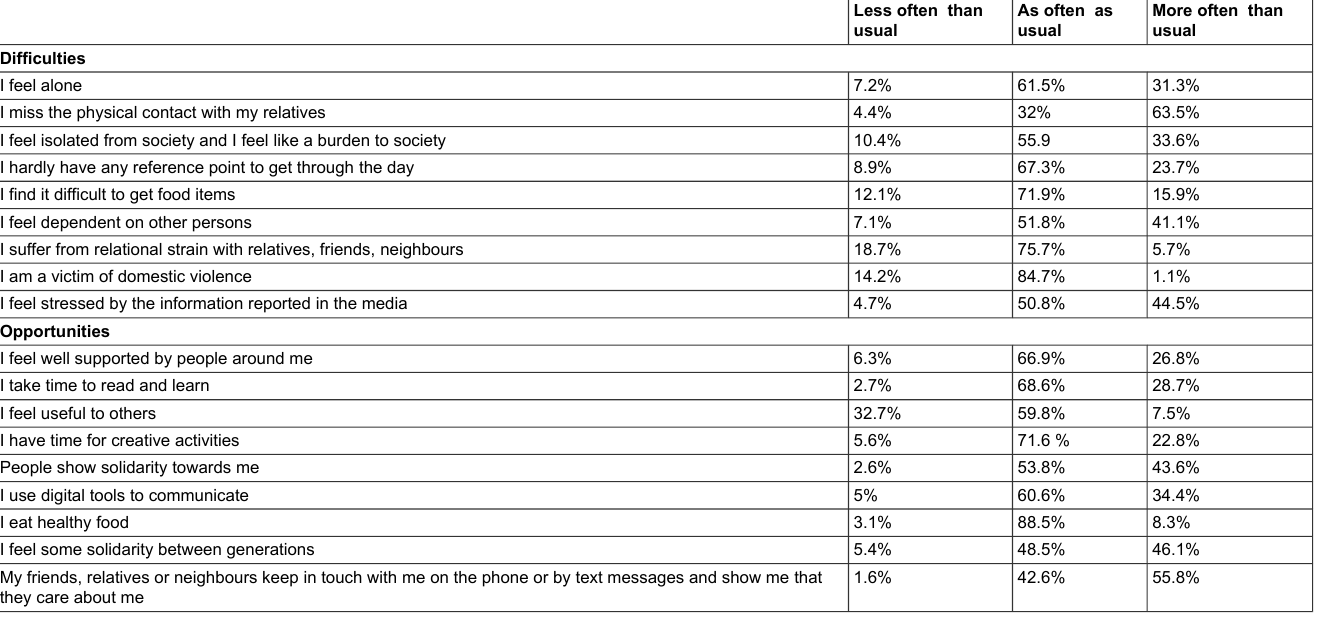
Table 3: The impact of the partial lockdown on the daily life of